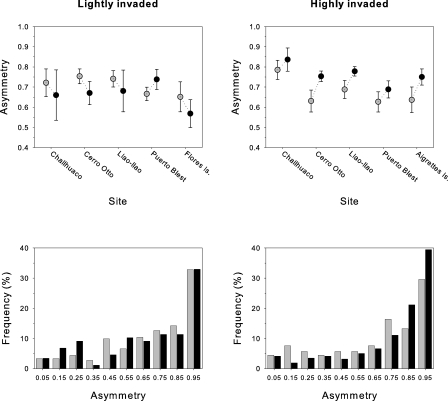
Means and Composite Frequency Distributions of Interaction Asymmetry for Pairs of Interacting SpeciesThe graphs depict asymmetries for interactions recorded in lightly invaded and highly invaded webs. Gray dots (upper panels) and bars (lower panels) indicate asymmetries for pairs of interacting native species, and black dots and bars depict pairs of interacting species in which at least one is alien. Sample sizes for each mean and frequency distribution can be derived from the column “Number of links” in Table 1. Error bars represent one standard error.